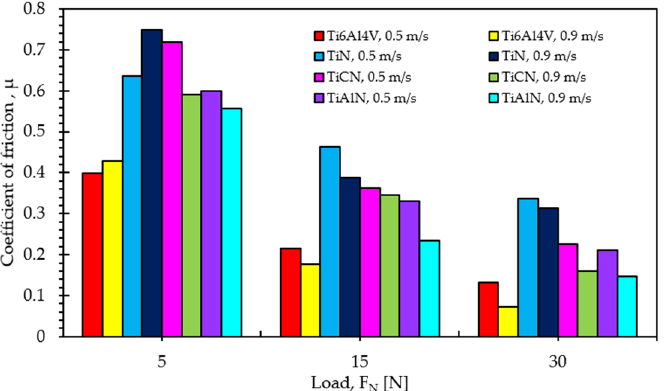
Figure 9. The variation in coefficient of friction with load (0.5 m/s–0.9 m/s sliding rate). When the coatings were compared according to their friction coefficient values, it was seen that TiCN and TiAlN coatings had a lower friction coefficient than TiN coatings. Surface roughness is an important parameter that affects the friction coefficient. In Figure 10a,b, the effect of surface roughness on the friction coefficient is presented. Measurement results showed that TiAlN and TiCN coatings have lower surface roughness values than TiN coatings. Uncoated Ti6Al4V alloy has high roughness. However, the lower coefficient of friction is due to the oxide layer formed on the surface, which is based on passivation. The alloy ′ s SEM image and EDX analysis also reveal this situation, as seen in Figure 11. The coefficient of friction decreases further as the sliding rate increases (Figure 9). Increasing the sliding rate increases the temperature. Increasing friction heat with increasing temperature increases oxidation and the developing oxide layer shows a lubricating effect [15]. When the friction coefficient of the TiN coating was examined, it was found to be higher than the TiCN coating. However, the lower wear rate of the TiN coating indicates that it can perform well at high temperatures [15,55].